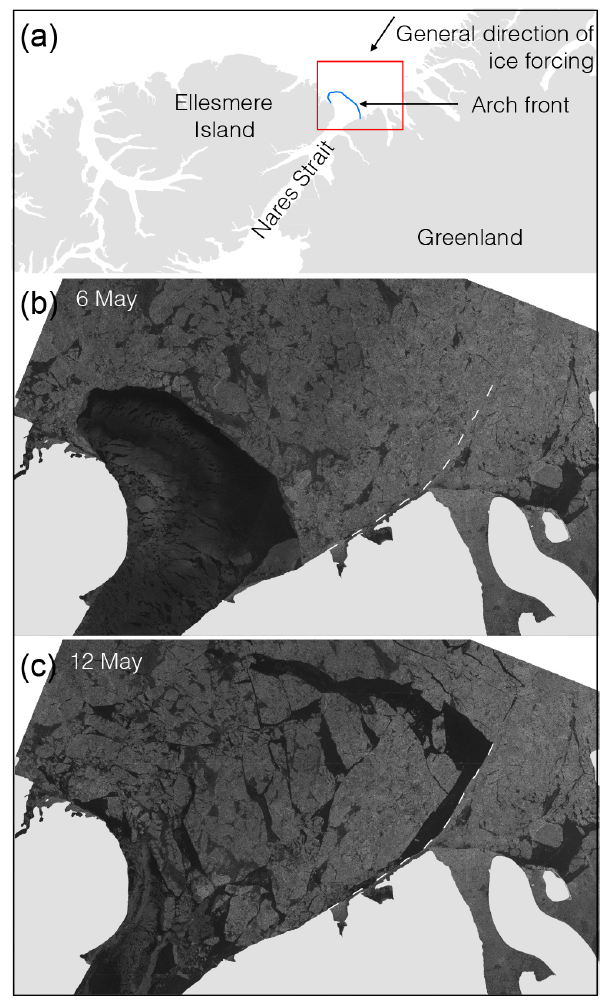
Figure 10. Map of Nares Strait (a) , and Sentinel-1 backscatter im- ages over the 2017 ice arch (blue line in a ) before (b) and after (c) failure. The line of failure is identified in (c) and marked as a dashed line in (b, c) . Land is masked out in light